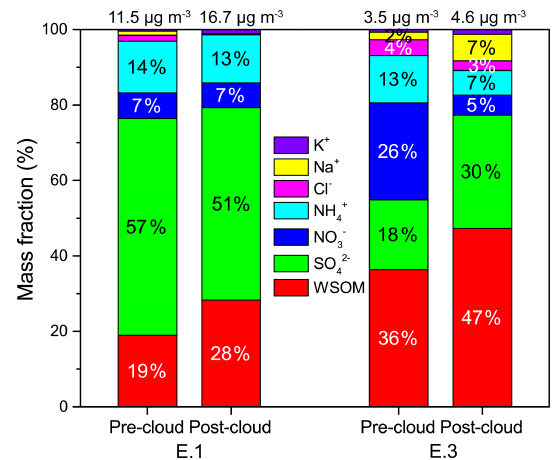
Figure 8. DOM / SO 2 − ratio as a function of cloud water pH. The 4 embedded graph shows the relationship between DOM and SO 2 − SO 2 − concentrations and pH values are both indicated by color 4 scales.